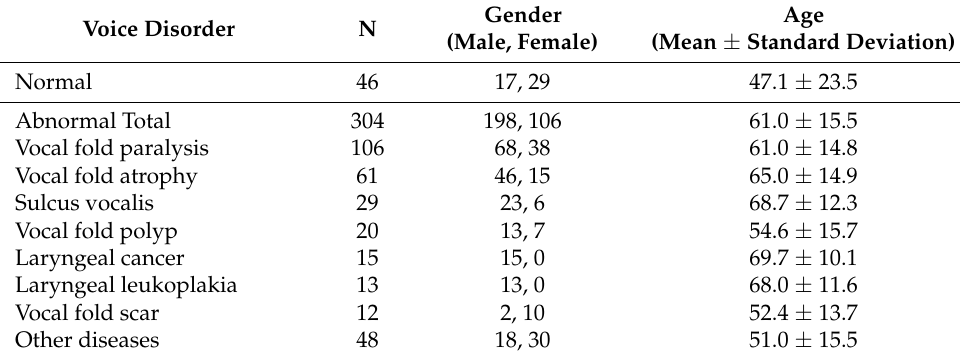
Table 1. Subject number by voice